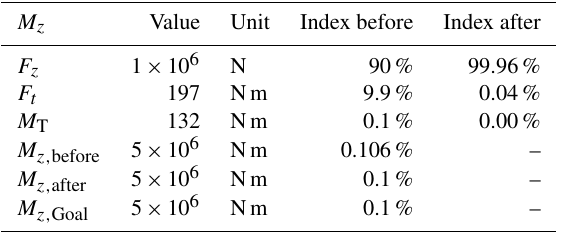
Table 5. Calibration torque moment measurement uncertainty re- duction by the MF